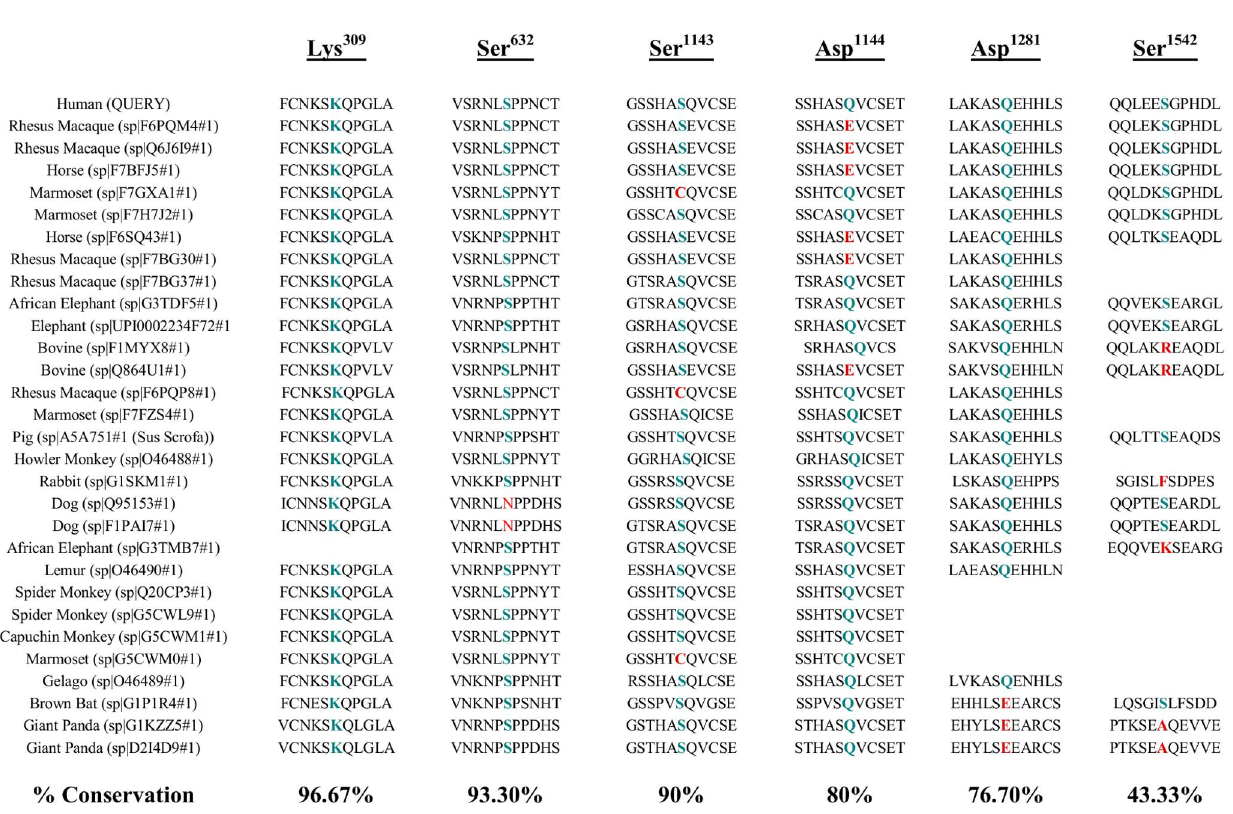
Figure 2. Multiple sequence alignment demonstrating evolutionary conservation of the six biologically characterized phosphorylated BRCA1 residues affected by missense variants of unknown clinical significance.